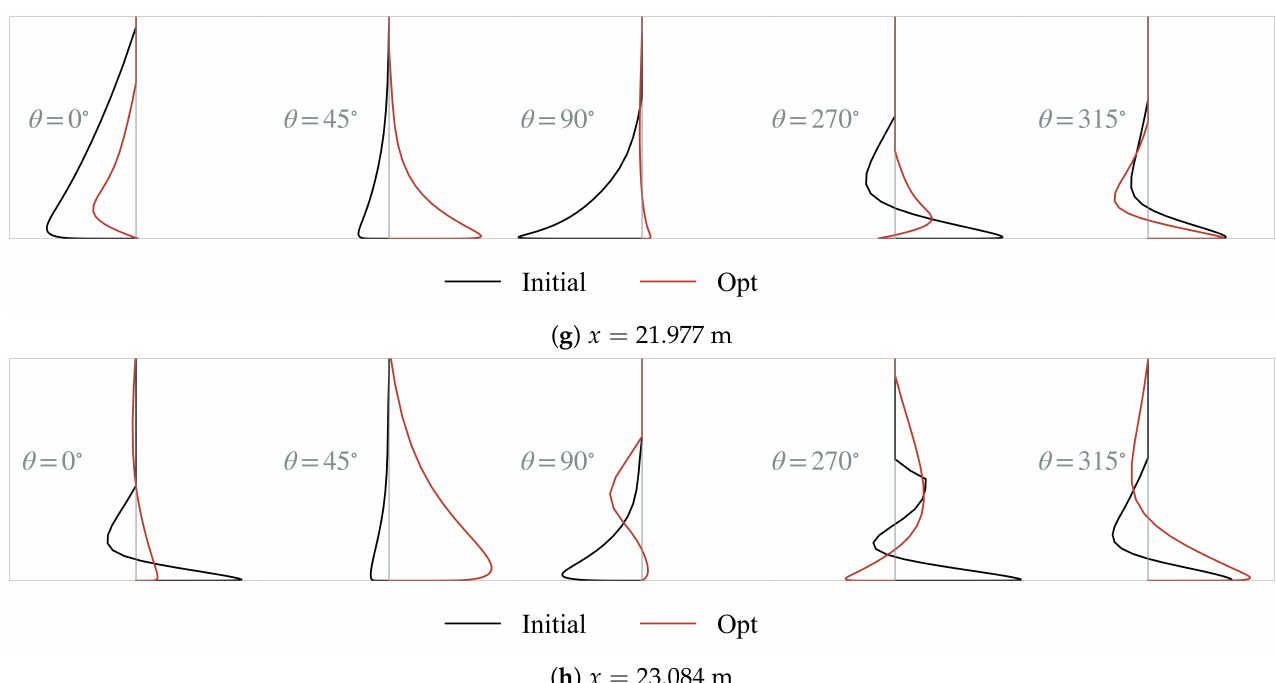
Figure 20. Comparison of crossflow velocity profile in eight cross-sectional positions of military aircraft.